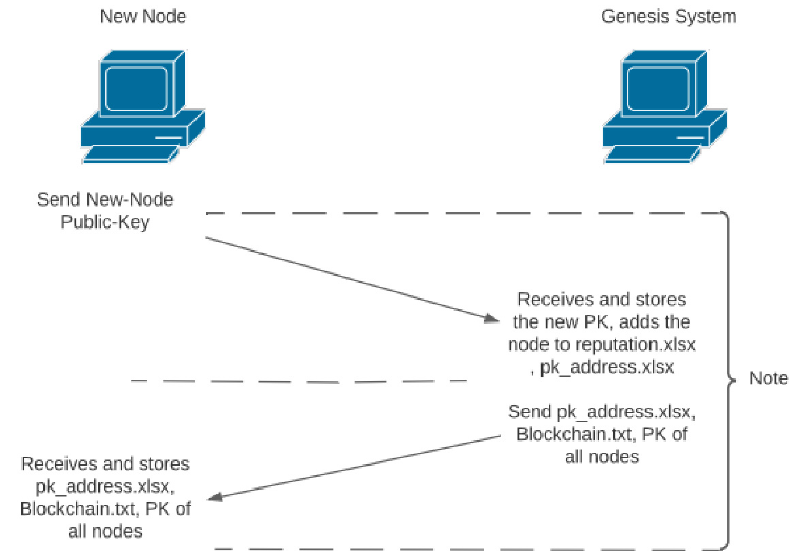
Figure 5. Initial connection and key